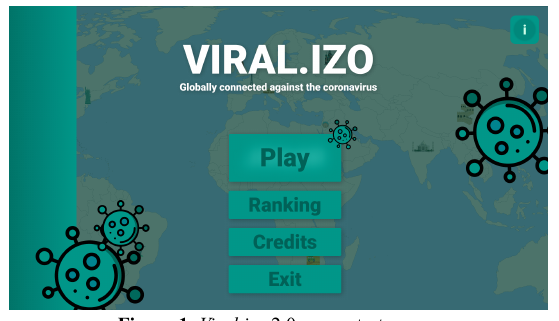
Figure 1. Viral.izo 2.0 game start